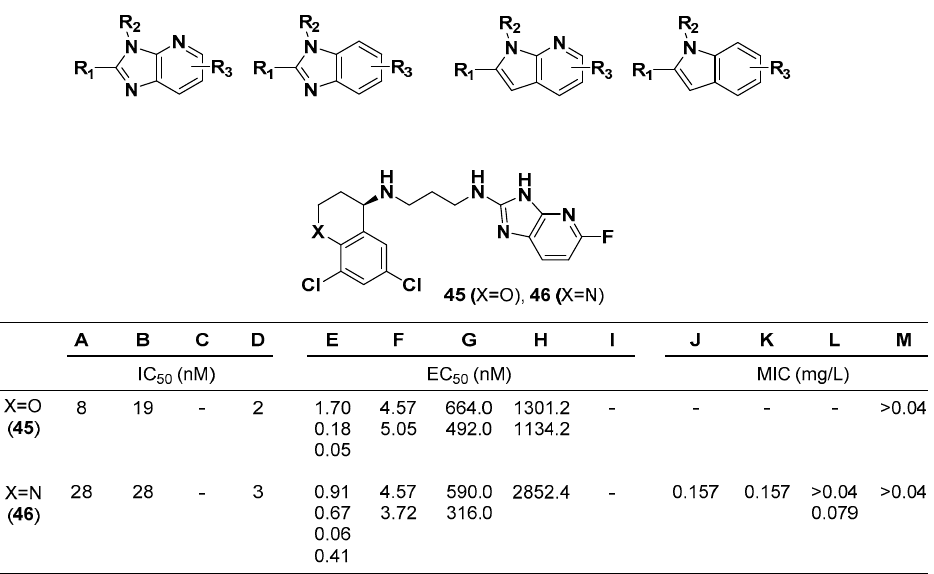
Figure 16. Four major scaffolds of bacterial methionyl-tRNA synthetase (MetRS) inhibitors and the biological activities of 45 and 46 against 13 different bacterial cell lines.